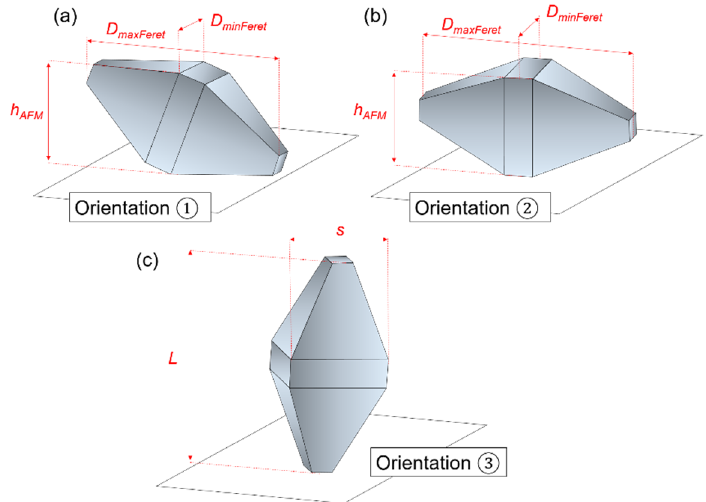
Figure 5. The three basic possible geometrical orientations for TiO 2 NPs in contact with the silicon substrate for the ideal case that the particles are isolated from each other. ( a ) NP with one of its {101} faces in complete contact with the substrate, ( b ) NP rests on one side of its {100} square base and ( c ) NP in standing position. In orientation 3 the parameters L (length) and s (square base side) are indicated.